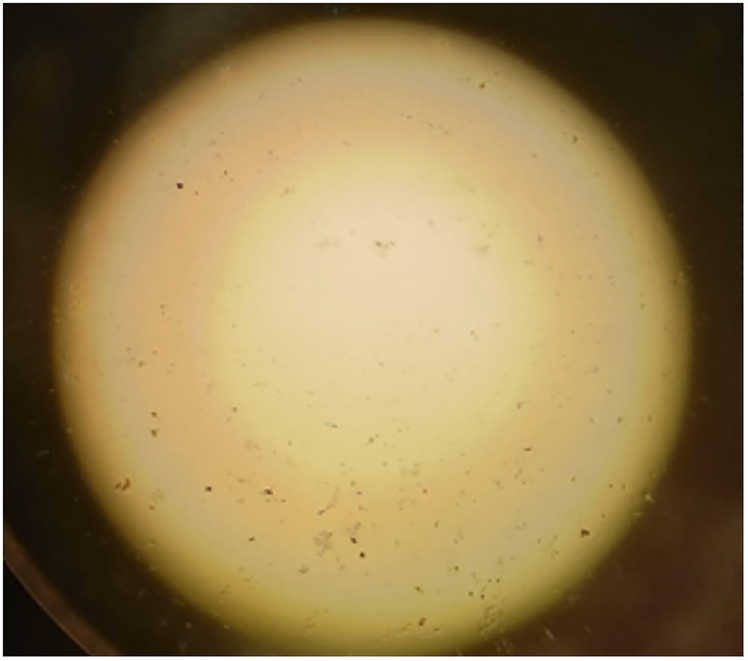
Fig 1. Photograph for the yellow form colony isolated from the crude oil supplemented by 9k medium. Also, in order to study the septic effect of bacillus strains as known colony, a biomixture of known bacteria ( Acidithiobacillus ferrooxidans and Acidithiobacillus thioxidans ) was made.